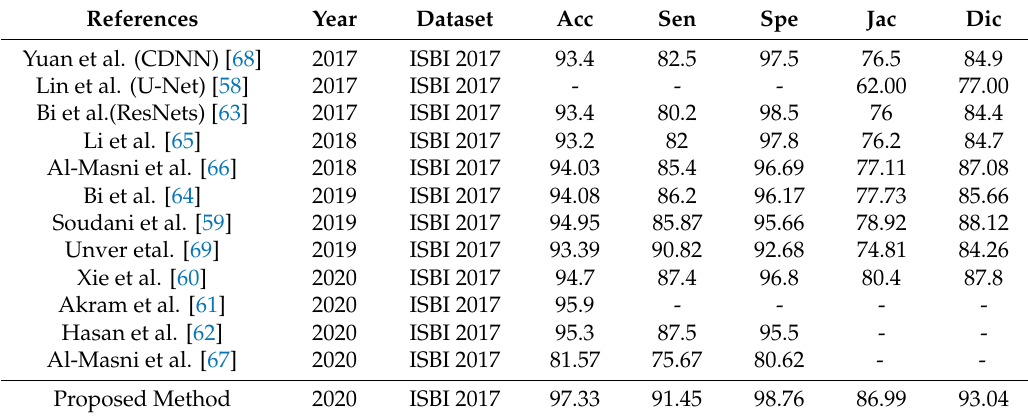
Table 10. The comparative study of the proposed segmentation performance (%) on ISBI 2017 dataset.